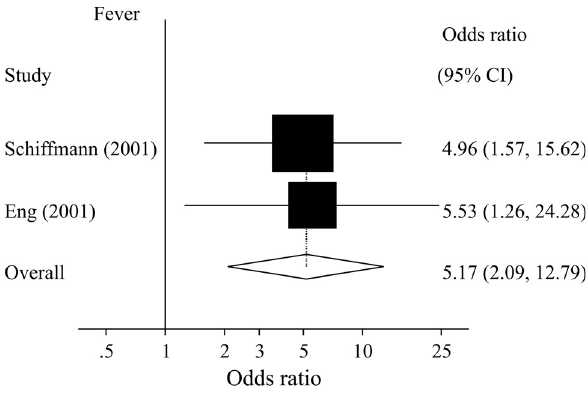
Figure 2 - Meta-analysis: increased odds of fever as an adverse event of enzyme replacement therapy (ERT) as compared to